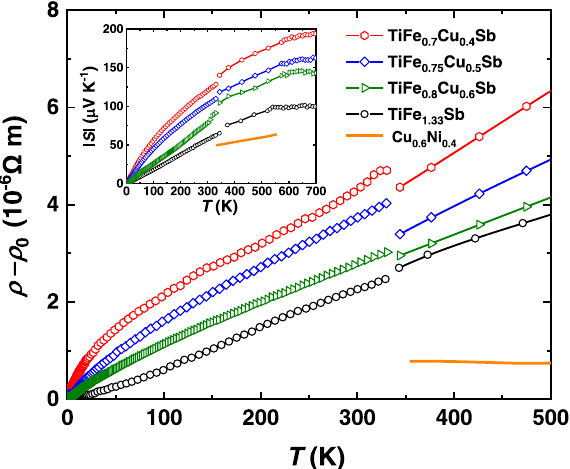
Fig. 2 Temperature-dependent zT values and Seebeck coef fi cients Fig. 1 Temperature-dependent electrical resistivities and Seebeck of TiFe x Cu 2 x -1 Sb and TiFe 1.33 Sb, all in lines with symbols. The zT coef fi cients of TiFe x Cu 2 x -1 Sb and TiFe 1.33 Sb samples. The data of values of CePd 3 , Yb 1.05 Al 3 , ZrCo 0.9 Ni 0.1 Bi, TiFe 0.6 Ni 0.4 Sb, TiFe 0.4 Ni 0.6 Sb, the Cu 0.6 Ni 0.4 alloy (solid orange line) are included for comparison 27 . fi tting to the low- ρ 0 is the resistivity at 0 K, which is obtained by temperature resistivity using the Bloch – Grüneisen model (Supple- mentary Methods and Supplementary Fig. 2 and Table 1). The resistivity of Cu 0.6 Ni 0.4 shown in this fi gure is the raw resistivity without eliminating the ρ 0 part.